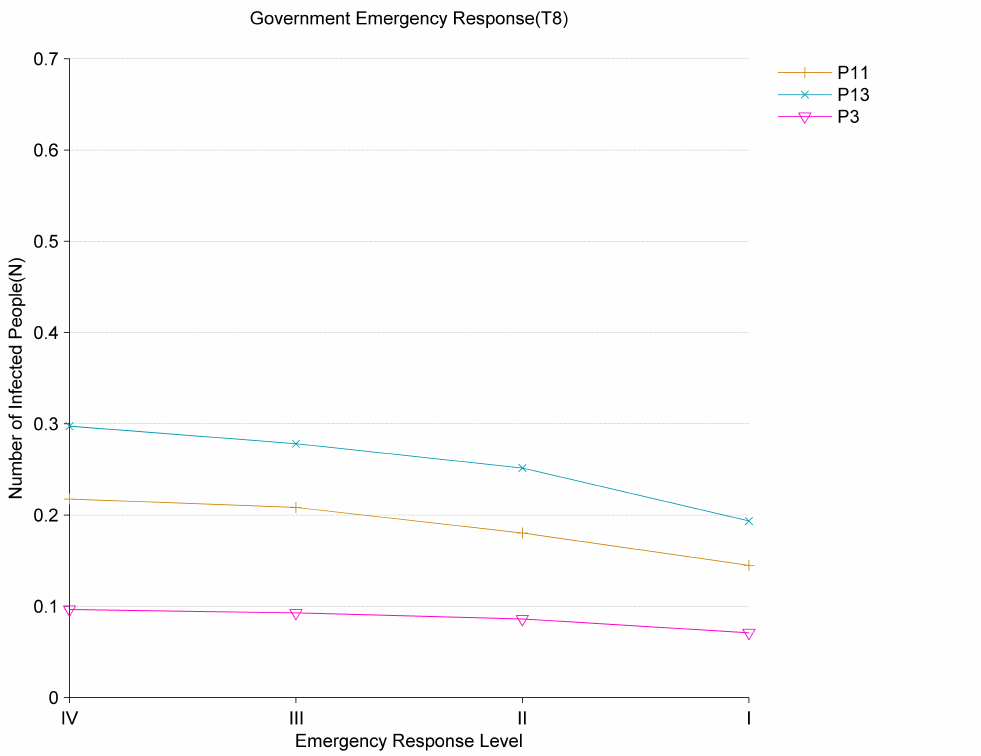
Figure 7. Impact of government emergency response (T8) on the evolution of the